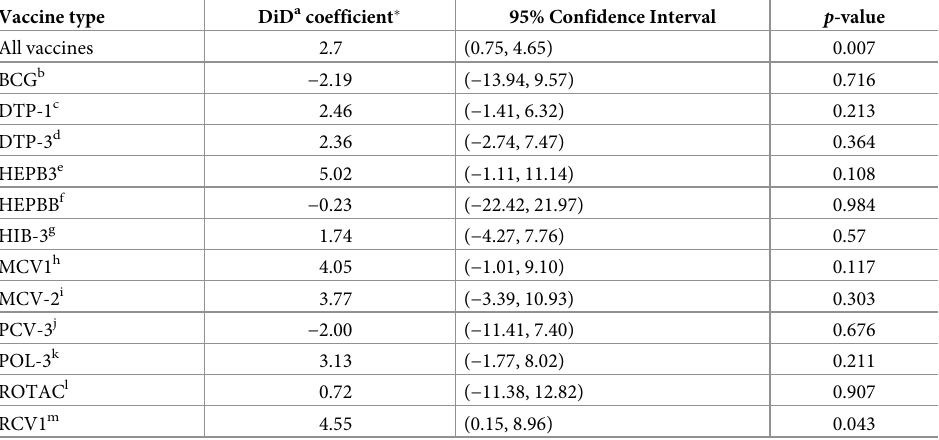
Table 4. Adjusted DiD analysis results of countries with high UHC index values (UHC SCI � 80) vs. all other countries (UHC SCI < 80) in immunization coverage by type of vaccine in pre-pandemic period (2010–2019) com- pared with pandemic period